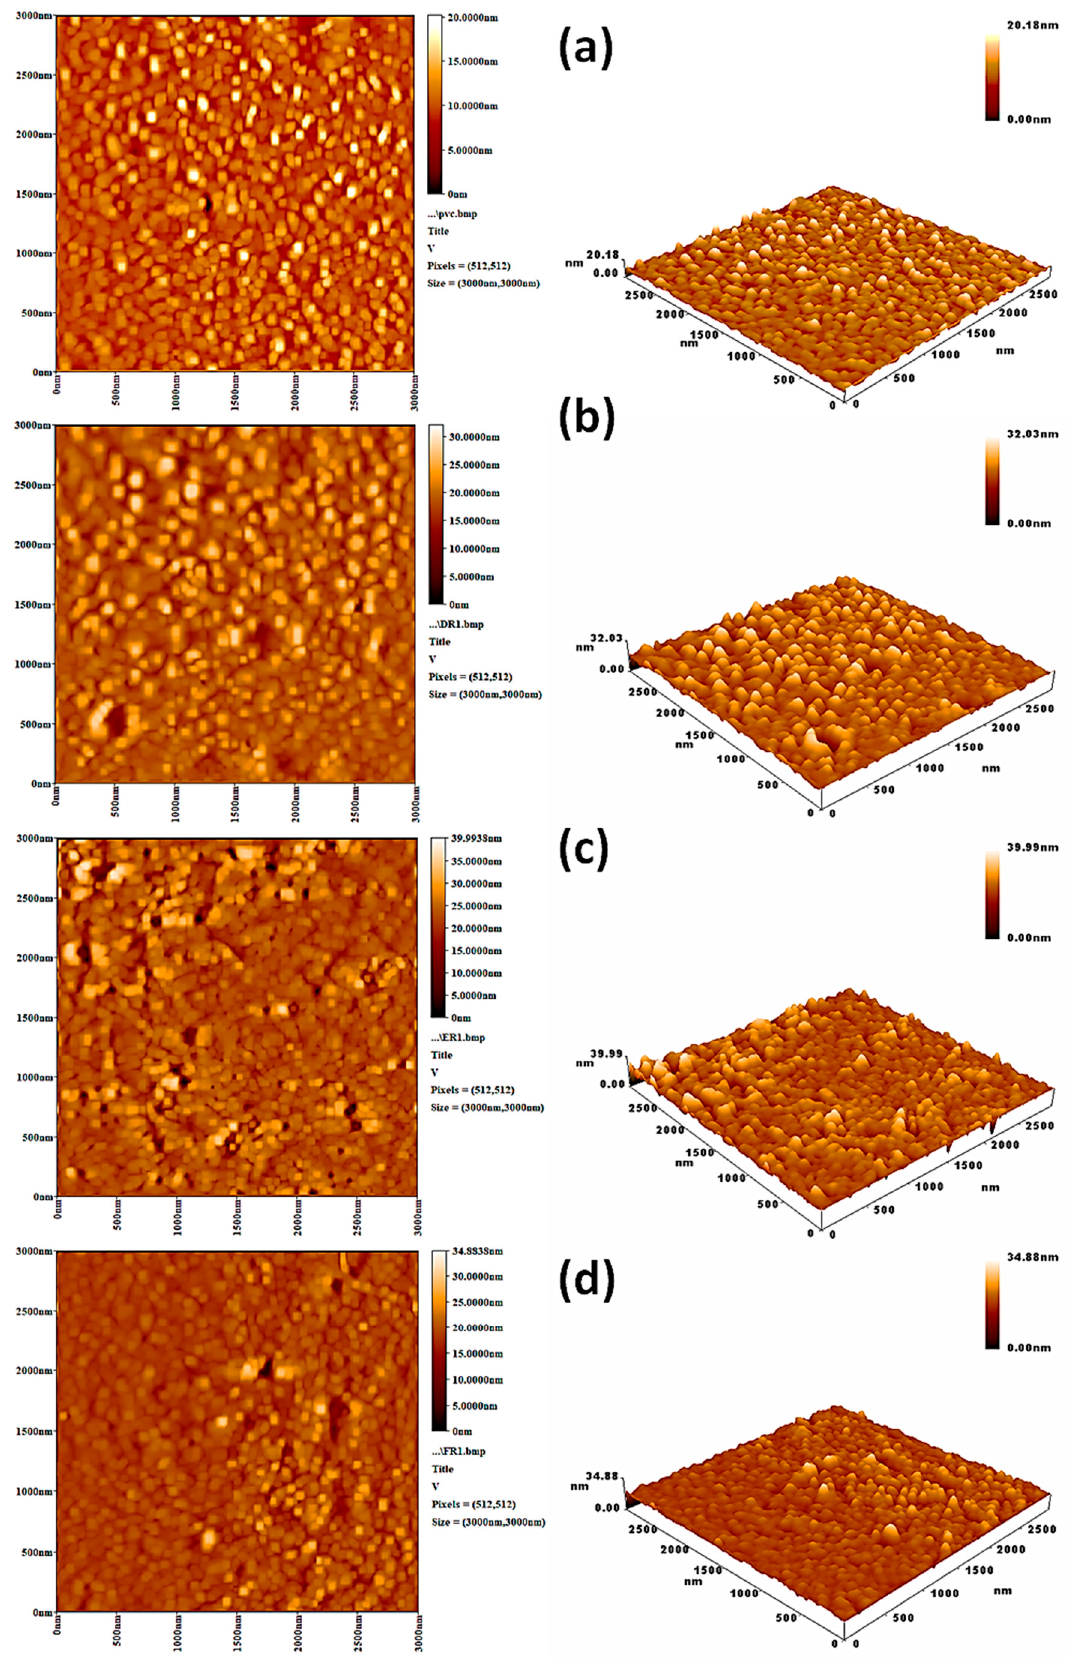
Figure 7. AFM images of irradiated ( a ) pure PVC, ( b ) PVC + 1 , ( c ) PVC + 2 , and ( d ) PVC + 3 .